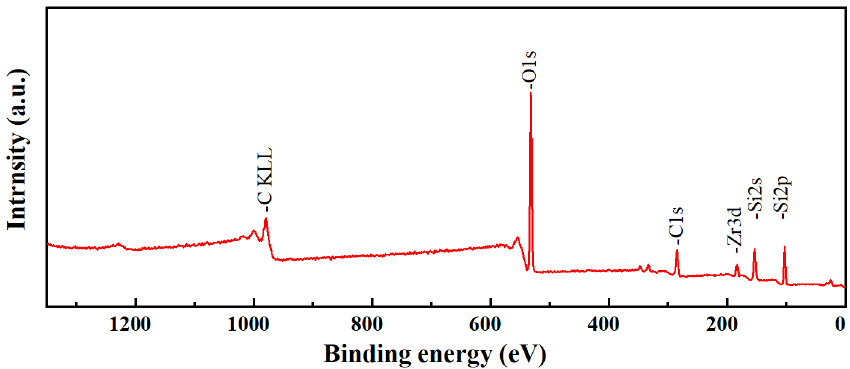
Figure 5. The survey XPS spectrum of ZrO 2 -MSiO 2 materials.